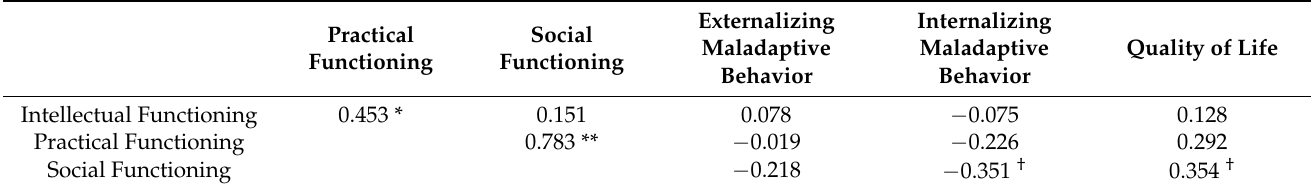
Table 3. Zero-order correlation matrix among intellectual, social and practical functioning variables; quality of life; and maladaptive behavior (N = 29).